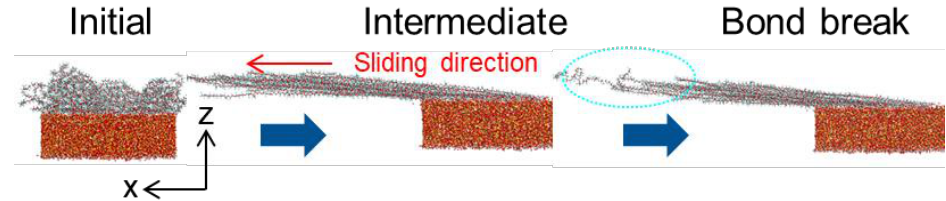
Figure 3. Snapshot of dynamic bond breaking during sliding process for SPFPE–silica interface (adapted with permission from Reference [30], Copyright 2019 American Chemical Society).